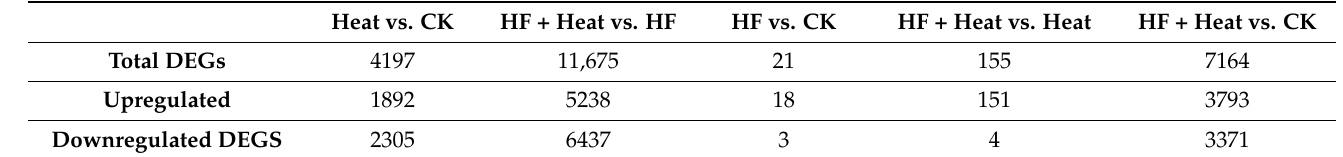
Table 1. Number of DEGS due to heat stress (Heat vs. CK), heat stress in the HF-infested plants (HF + Heat vs. HF), HF infestation (HF vs. CK), HF infestation in the heat-stressed plants (HF + Heat vs. Heat), and the combined effect of heat stress and HF infestation (HF + Heat vs. CK). Heat vs. CK HF + Heat vs. HF HF vs. CK HF + Heat vs. Heat